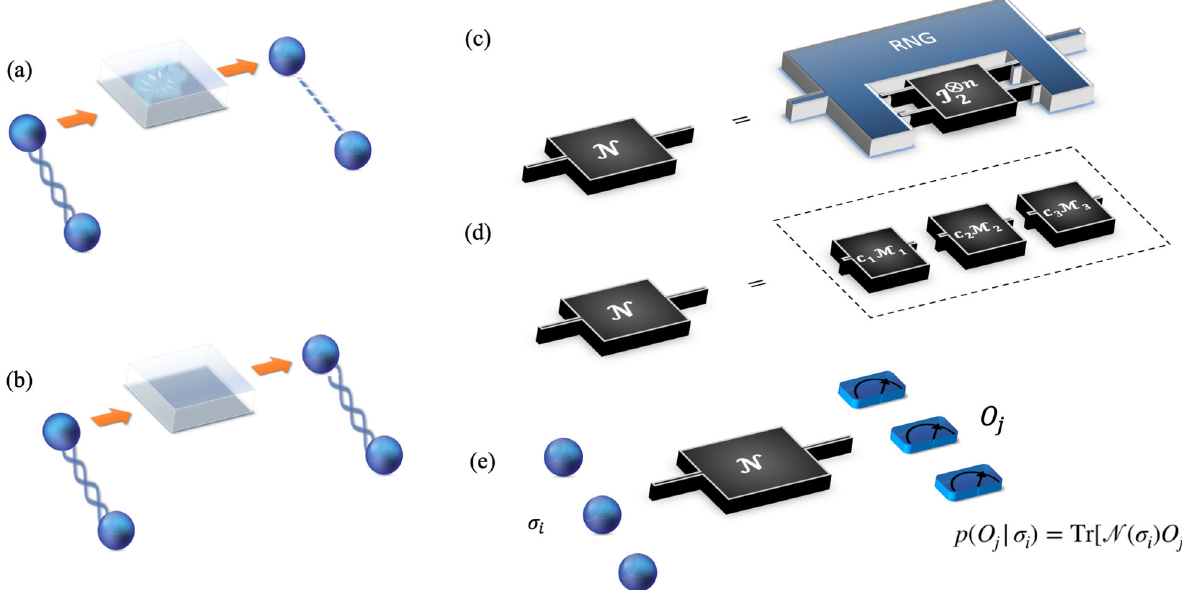
Fig. 1 A schematic of the robustness of quantum memory (RQM) and its operational meanings. This work focuses on the resource theory of quantum memories. We de fi ne a entanglement-breaking memories as free resources and propose the RQM as a resource measure of b a quantum channel. We consider three operational interpretations of the measure in c one-shot memory synthesis with resource non- generating (RNG) transformations; d classical simulation of the measurement statistics of quantum memory; and e a family of two-player non- local quantum games generalising state